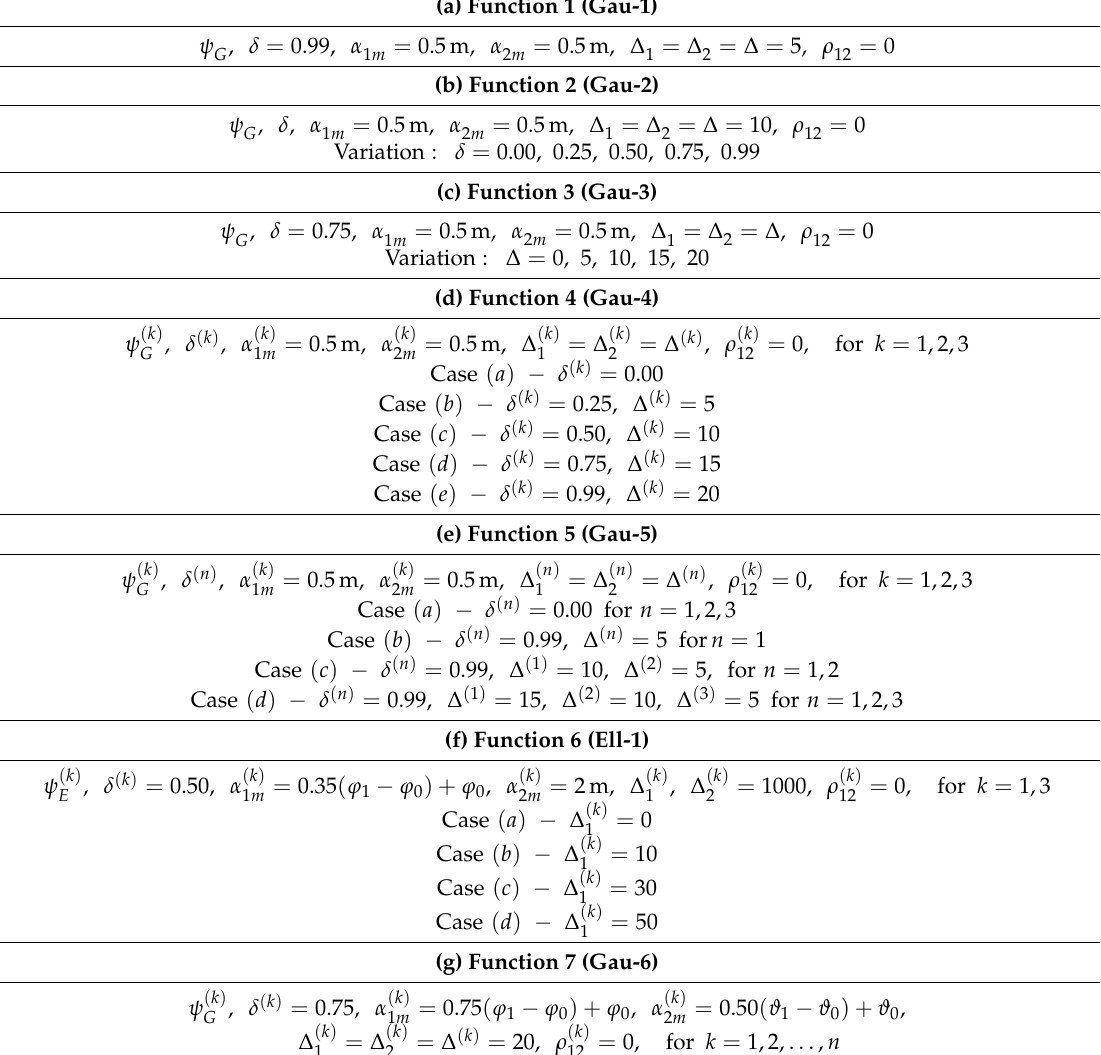
Table 5. Analytical expressions of the functions used to model the